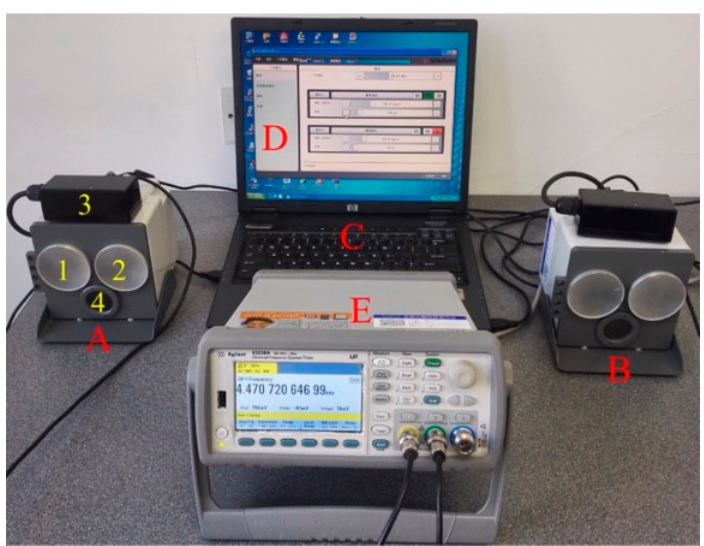
Figure 10. Realization and traceability of the simulation system.